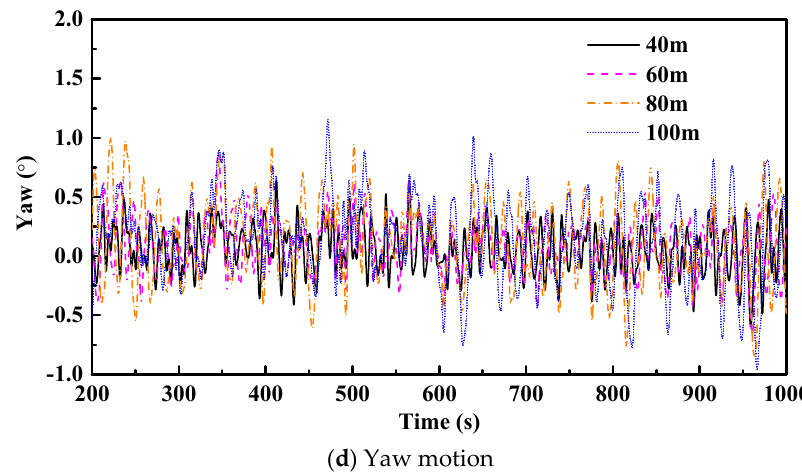
Figure 6. Time series of platform motions for different tether lengths.